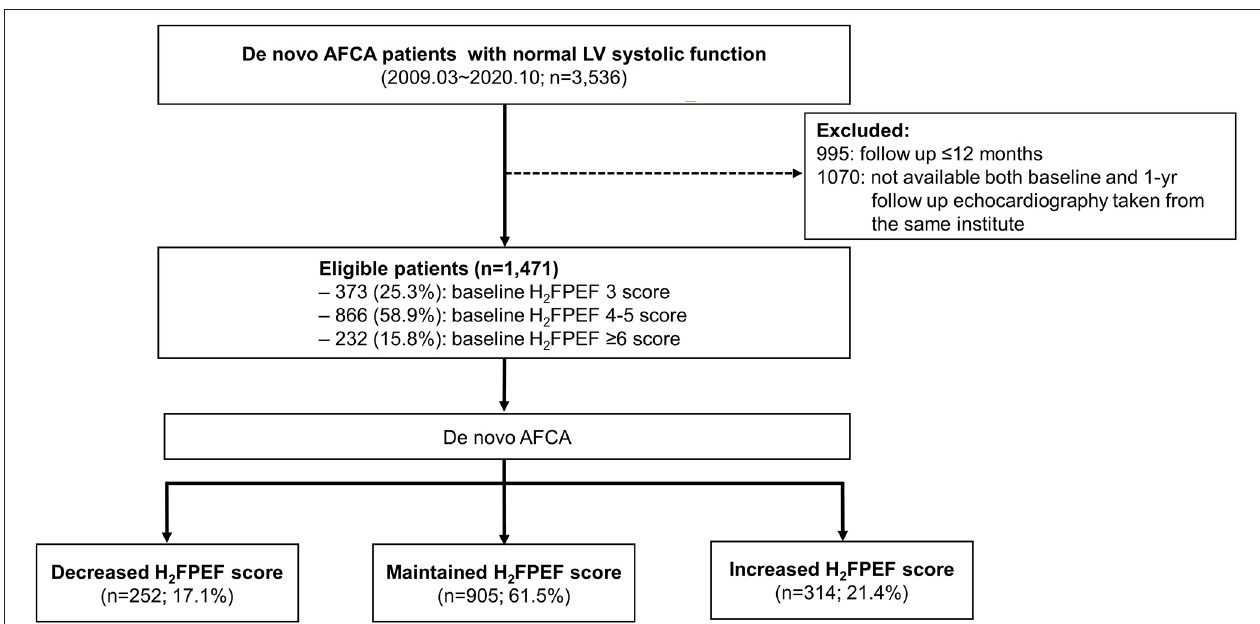
FIGURE 1 | Screening and study flowchart of the patient selection. AF, atrial fibrillation; AFCA, atrial fibrillation catheter ablation; LV, left ventricular.